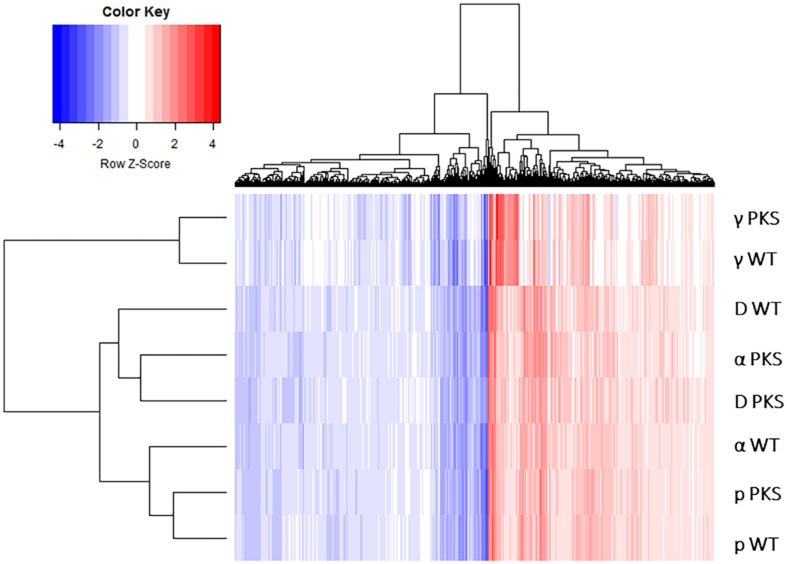
Heatmap depicting the log2-fold change values of genes within the six particle and the two γ-IR-responding datasets. Genes evaluated were those that were found to be differentially expressed (with an FDR value < 0.05) in all of the six particle datasets.